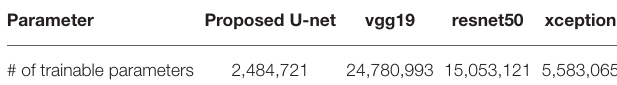
TABLE 6 | The complexity of alternative U-net models with different encoder backbones on arabidopsis top view images.